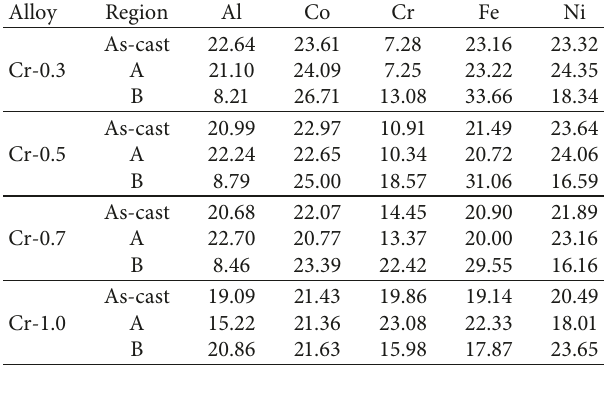
Figure 5: True stress-strain curves of the alloys Cr-0.3, Cr-0.5, Cr- 0.7, and